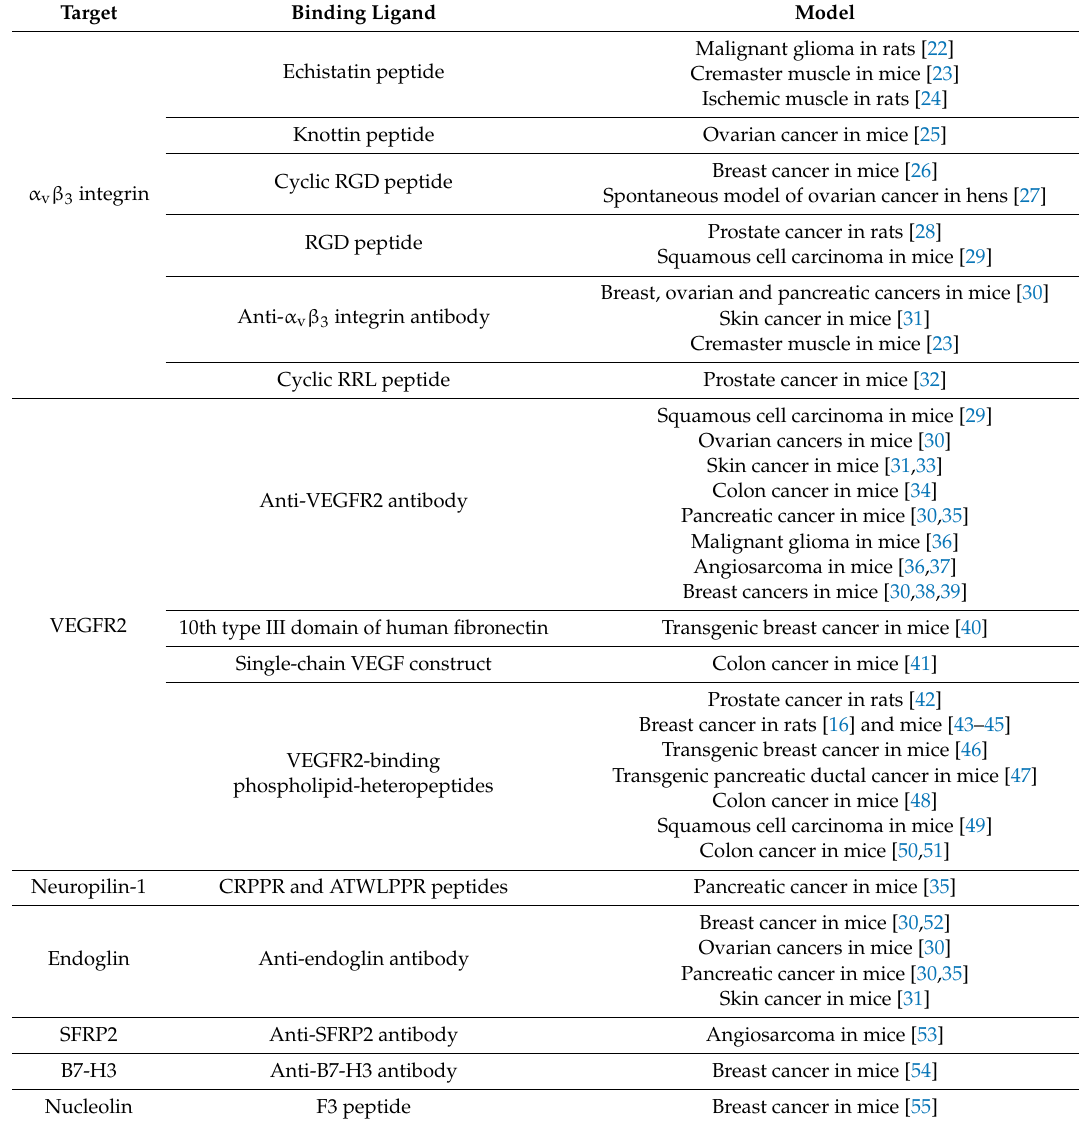
Table 1. Summary of intravascular targets investigated for molecular US